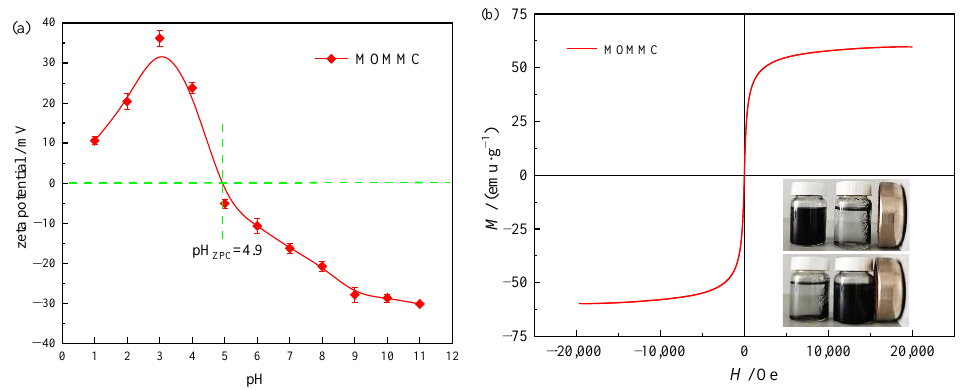
Figure 5. Zeta potential ( a ) and VSM magnetization curve ( b ) of MOMMC.